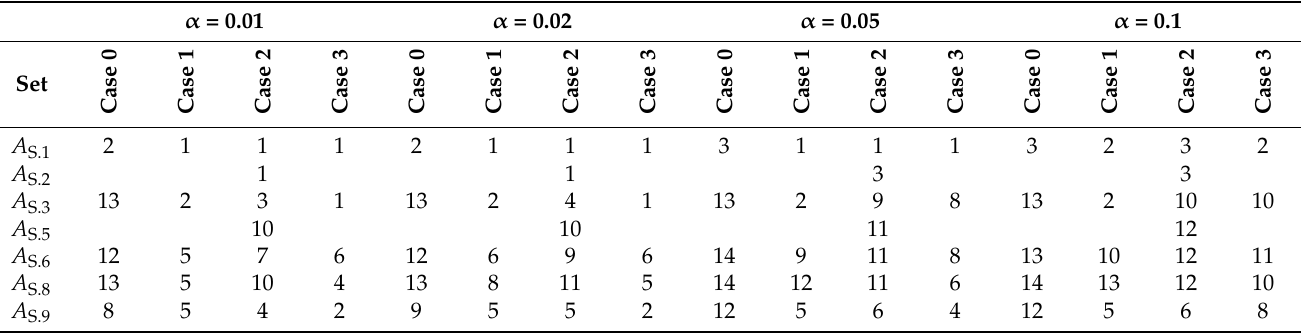
Table 24. The Cardinality of the Influence Sets Associated with the Dominant Nodal Reactive Powers in Case 0, Case 1, Case 2, and Case